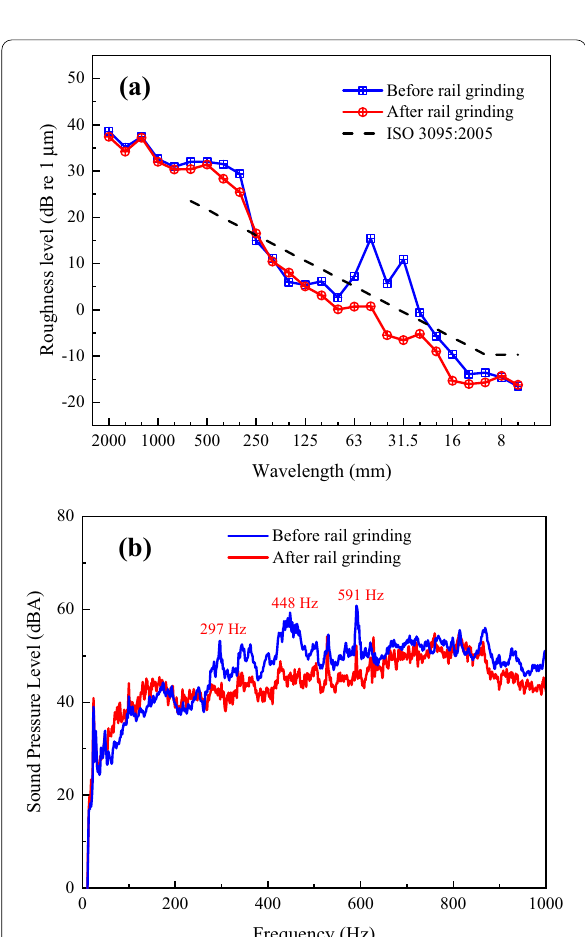
Figure 4 Effect of rail roughness: ( a ) roughness spectrum and ( b ) sound